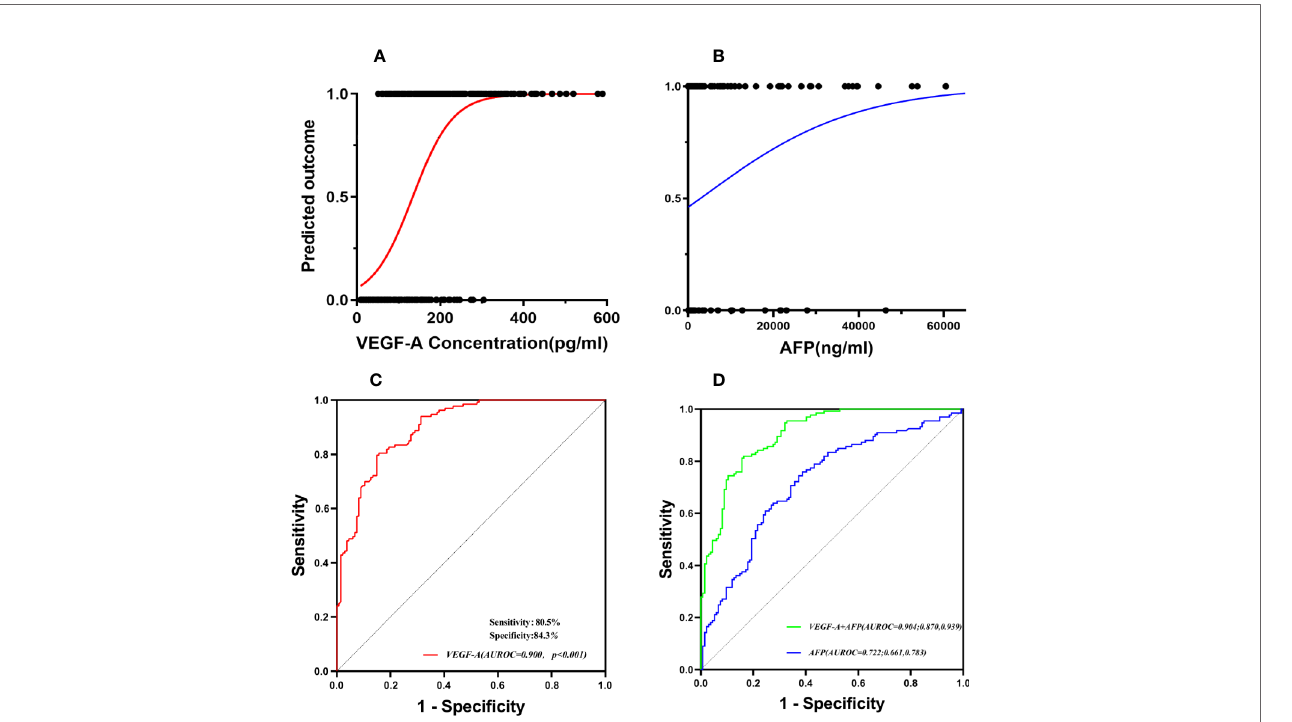
FIGURE 4 | Serum VEGF-A was a predictive factor of MVI in HCC patients. The probability of MVI increased along with the increase of VEGF-A and AFP concentrations (A, B) . (C) The cutoff value of VEGF-A concentration was determined by receiver operating characteristic curve (ROC) analysis. (D) The combined two indicators (VEGF-A and AFP) were more effective than AFP alone in predicting